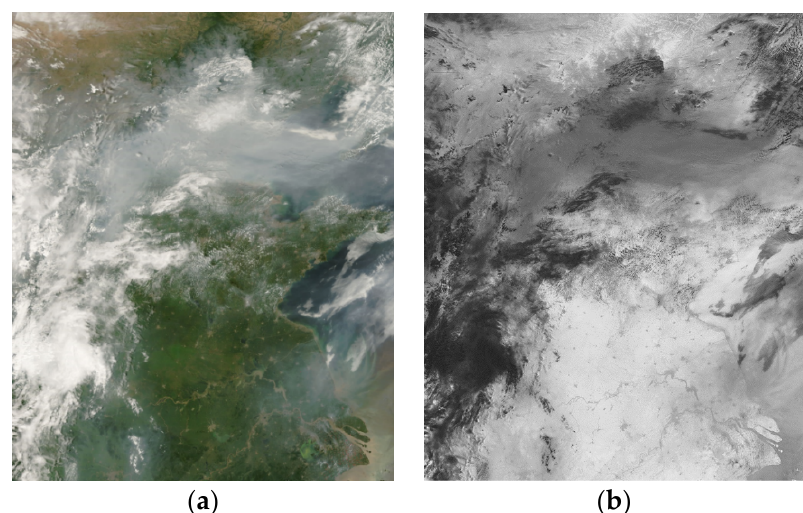
Figure 2. Schematic diagram of ( a ) Original haze image; ( b ) Estimated transmission map.